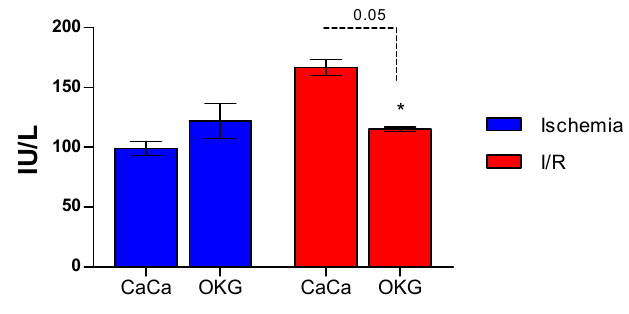
FIGURE 2 - Plasma CPK levels (international units per liter) in samples from CaCa and OKG-pretreated rats. Bars represent mean±SD of ischemia (blue bars) and reperfusion (red bars) groups at the end of the ischemia (30 min) and reperfusion (30 min). CPK levels in OKG treated rats decreased significantly at the end of reperfusion compared with CaCa- treated rats by Student´s t test.